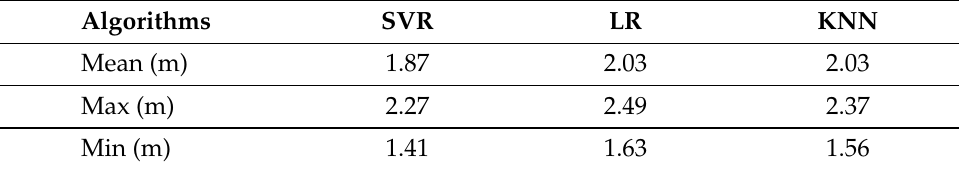
Figure 5. ADE and AADE results for 21 runs. Table 5. Mean, minimum and maximum of ADE for three algorithms.